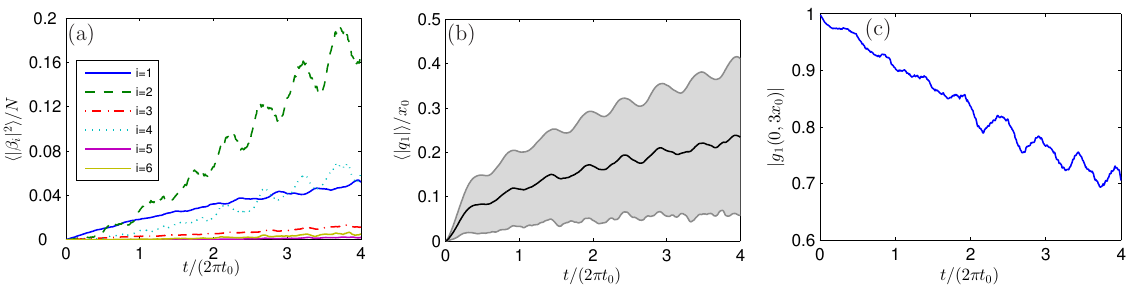
( a ) Average response of a single trajectory, decomposed into Bogoliubov linearized collective excitations, mode occupation numbers (cid:104)| β lowest six modes. ( b ) Average center-of-mass displacement q for a single measurement conditioned